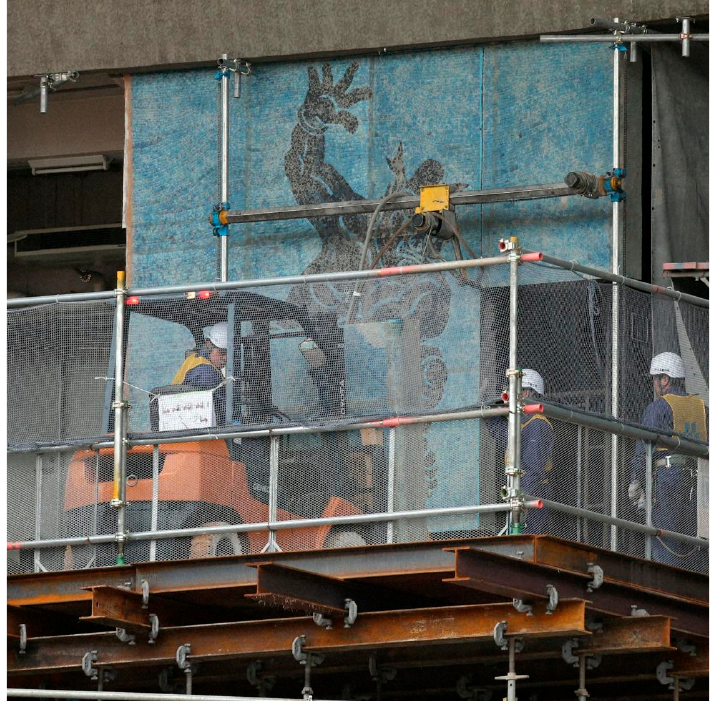
Figure 4. The dismantling of Hasegawa’s Nomi no Sukune mosaic at the former National Stadium, 2016. Reproduced with permission from Kimitaka Takeichi, reprinted from The Mainichi Newspa- pers.